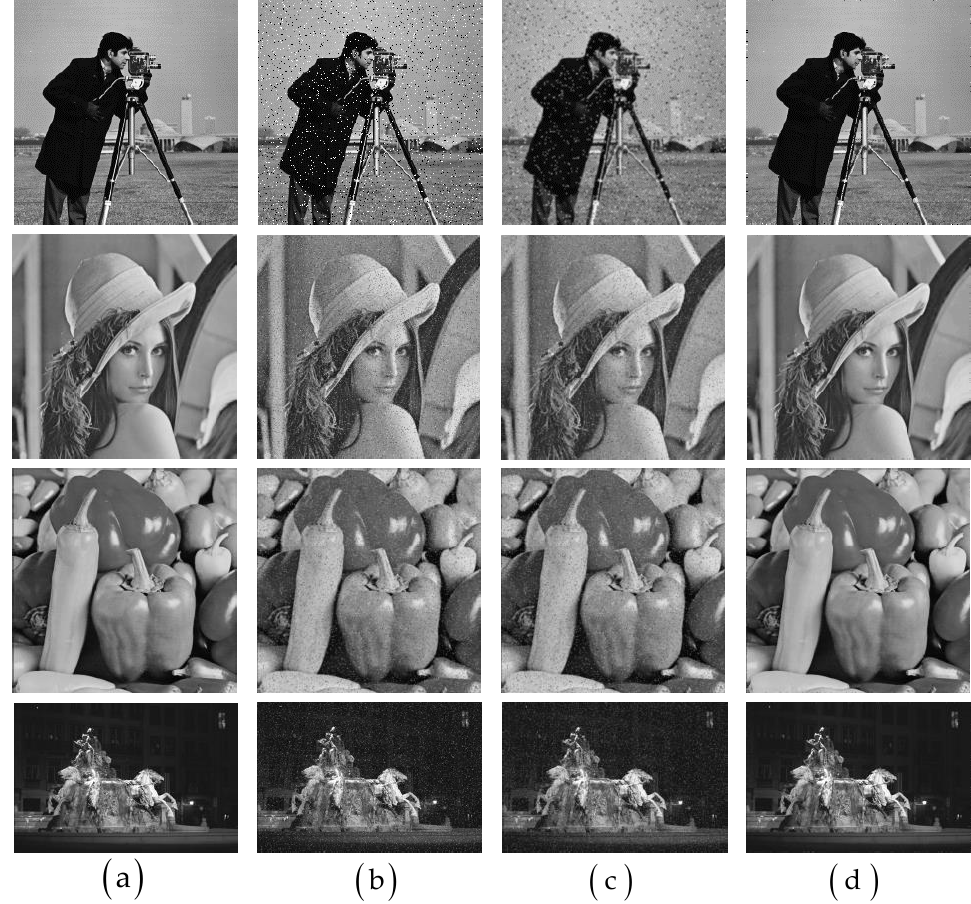
Figure 7. Comparison diagram of proposed Median Filter and Gaussian Filter, ( a ) is the original image, ( b ) is the image with 5% salt and pepper noise, ( c , d ) are the denoising results of Gaussian Filter and proposed Median Filter respectively. Table 1. Comparison of the PSNR and SNR of the two algorithms on four standard digital images.